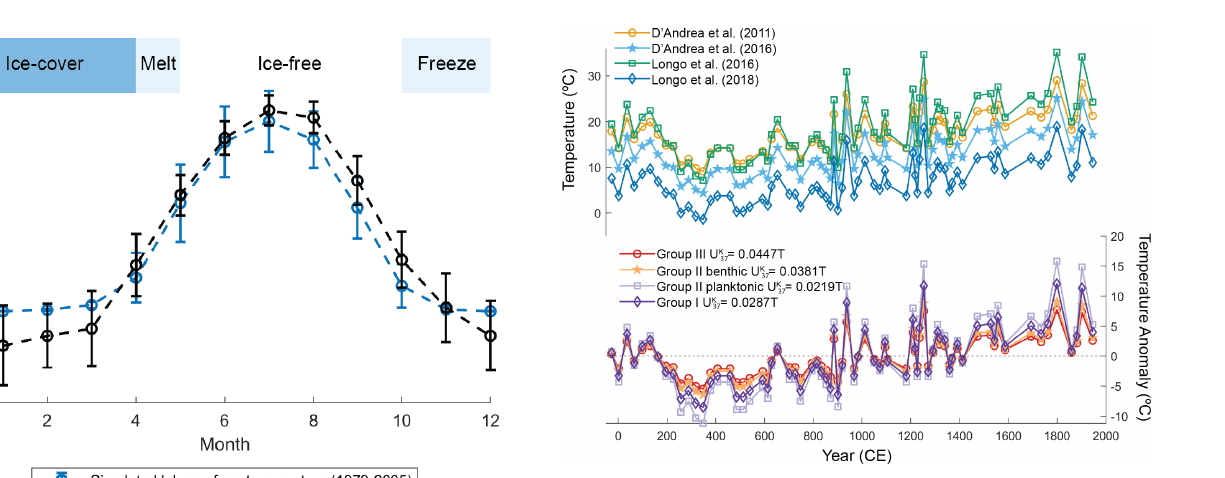
Figure A4. Alkenone calibrations from previous studies includ- = 0 . 0296 T − 0 . 80 (D’Andrea et al., 2011), U K = ing (a) U K 37 37 = 0 . 021 T − 0 . 68 0 . 0284 T − 0 . 655 (D’Andrea et al., 2016), U K 37 = 0 . 029 T − 0 . 49 (Longo et al., 2018). (Longo et al., 2016), and U K 37 (b) Temperature anomalies calculated from slopes previously deter- mined by D’Andrea et al. (2016) for Group III, Group II benthic, Group II planktonic, and Group